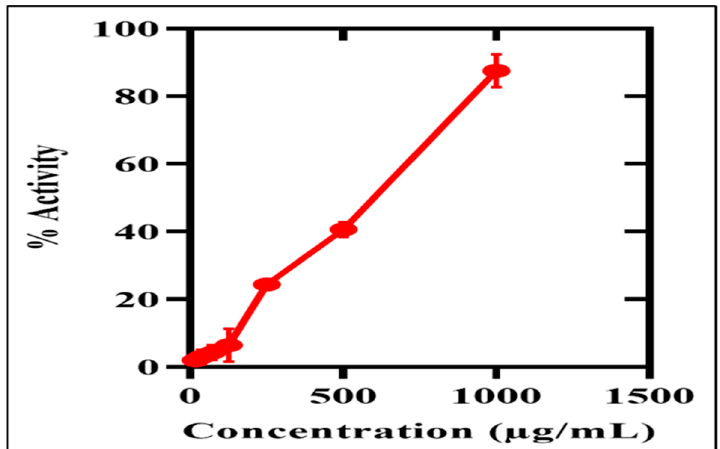
Figure 13. Mycelial growth and Zone of inhibition of various fungal strains. ( A ) A. flavus , ( B ) F. solani , ( C ) A. niger , ( D ) C. albicans , ( E ) M. racemosus , ( F ) control ( Ampicillin ) against Ag 2 ONPs . Figure 14. The antihemolytic potential of P. alsinaefolia -mediated Ag 2 ONPs.